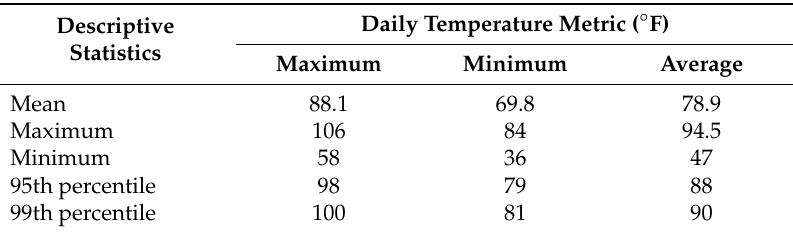
Table 2. Descriptive statistics of daily temperature metrics in May–September during